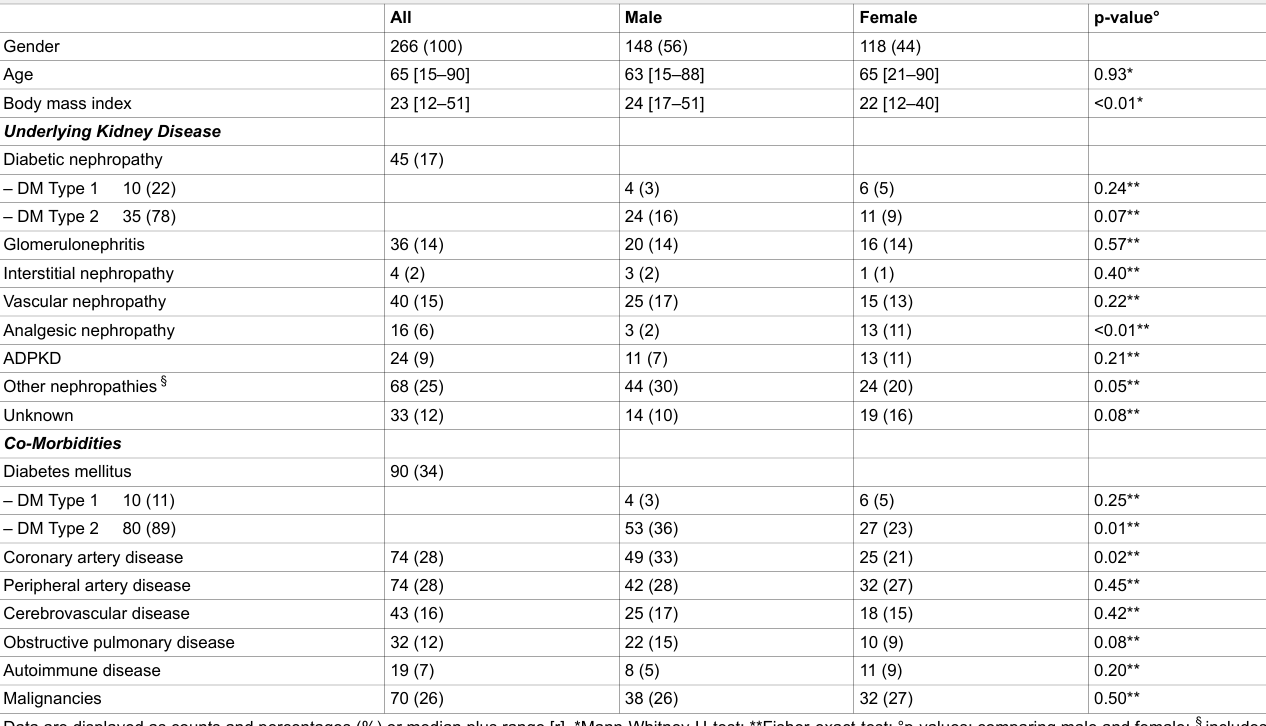
Table 1: Baseline characteristics of 266 patients undergoing chronic haemodialysis.